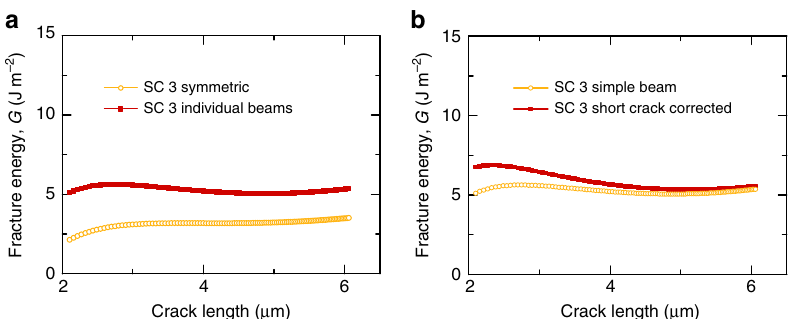
Fig. 4 Effect of different assumptions on DCB geometry. a Plot showing how the fracture energy would be erroneously measured should the DCB tested be treated as perfectly symmetrical. For “ SC 3 symmetric ” the energy elastically stored in the system was measured by simply doubling the energy stored in one of the two beams. It is worth noting that the fracture energy could be underestimated or overestimated depending on whether the beam considered is moving more or less than the other beam, respectively. “ SC 3 individual beams ” were measured by measuring the energy stored in each beam. b “ SC 3 simple beam ” fracture energy is measured applying the simple beam theory assumptions, whereas the values in red are corrected to take into account the effect of shear when the crack is short